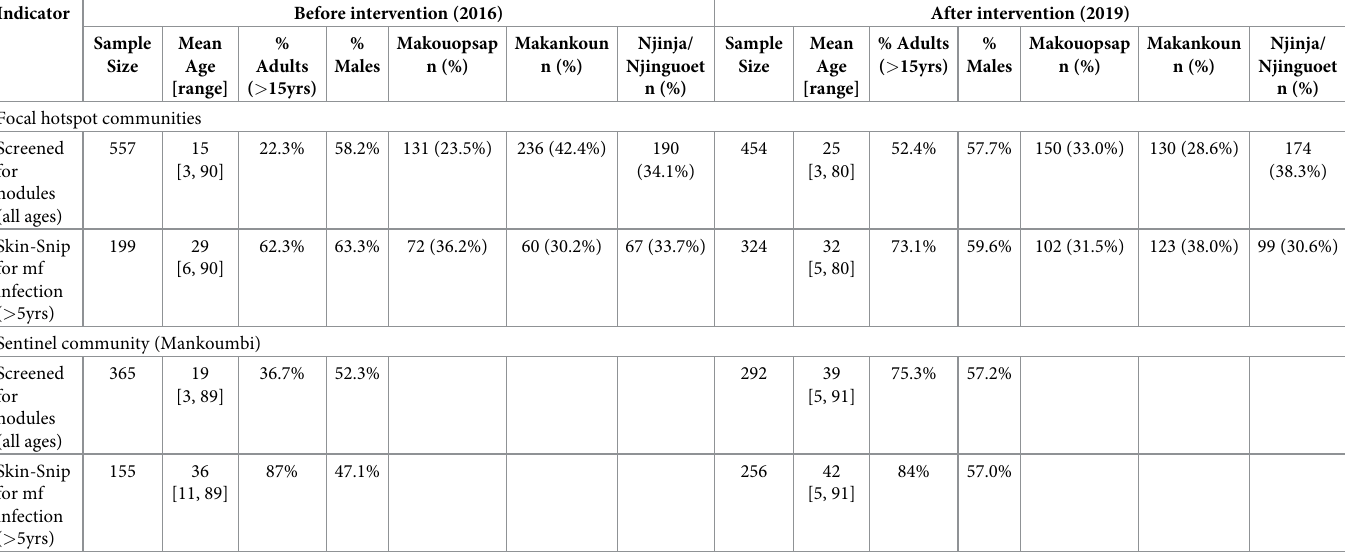
Table 4. Population description in focal